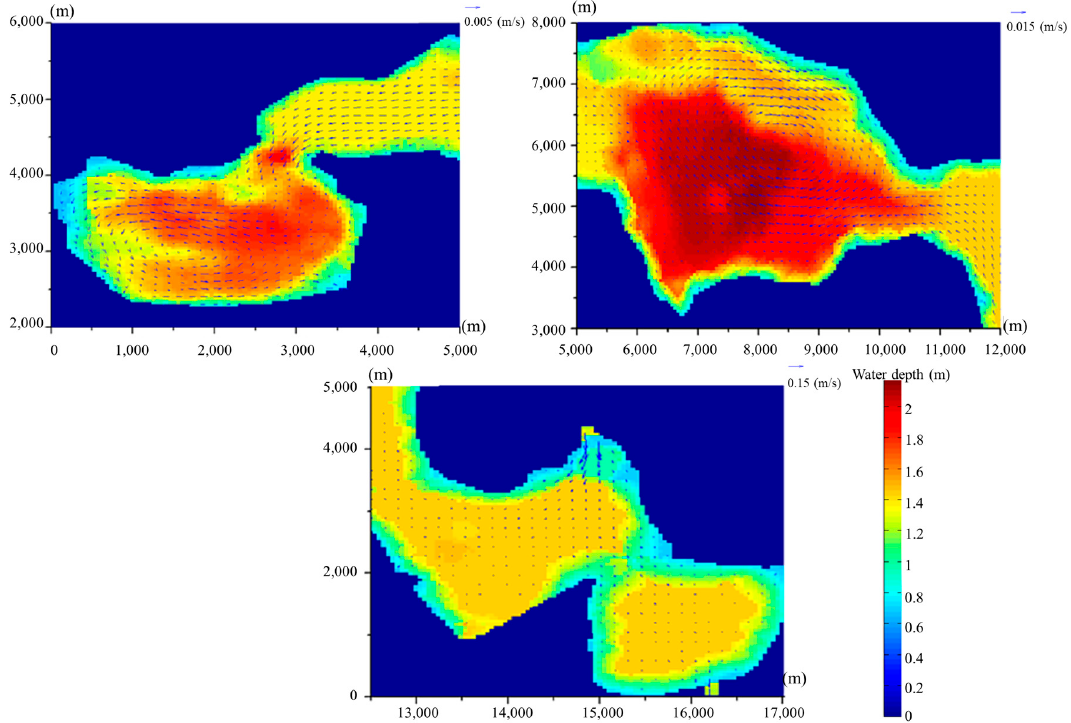
Figure 7. Water depth and velocity vectors after 5 days.